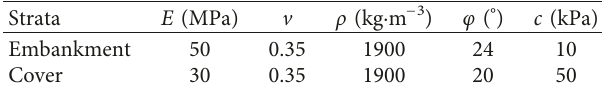
Figure 19: Numerical simulation of the embankment construction process. Table 2: Basic material properties of embankment and